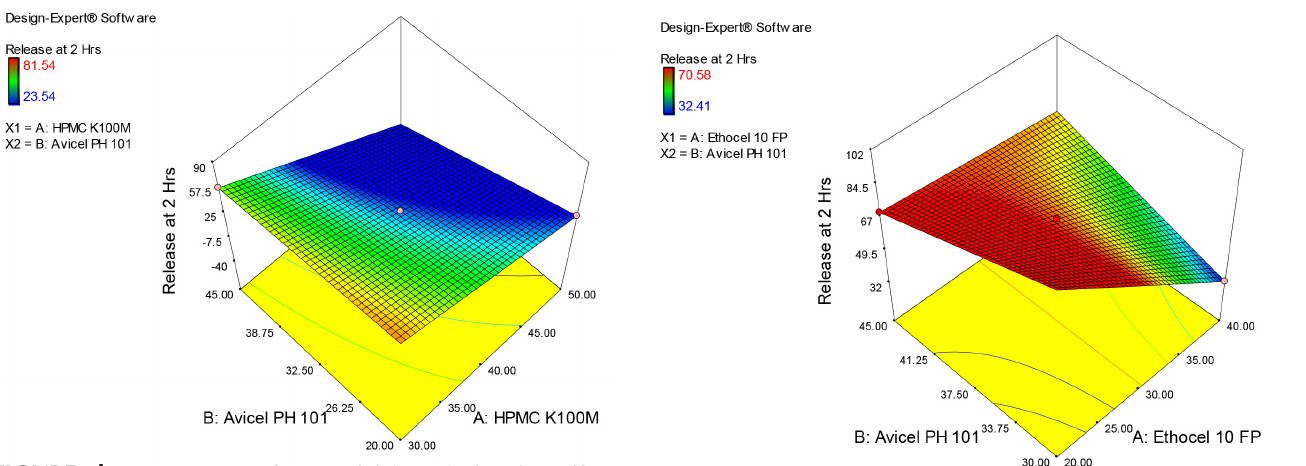
FIGURE 6b - Response surface model (RSM) showing effect of independent variables HPMC K100M and Avicel pH 101 on Drug release in 2 hours.